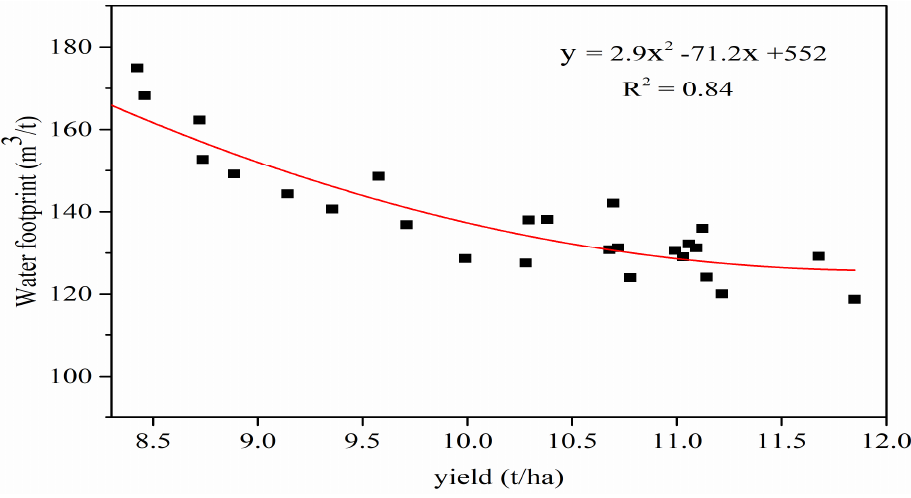
Figure 8. Relationship between yearly crop yield and yearly WF from 1990 to 2016.